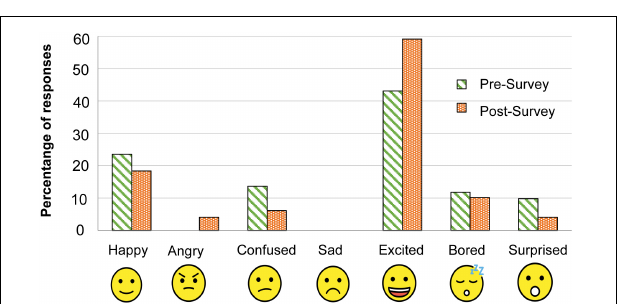
FIGURE 3 | Frequency of engagement sub-categories, positive and negative emotion. Results depicting the frequency of positive and negative emotions found in question 1 of the pre and post survey. These emotions were coded through thematic analysis of question 1, which asked students to “write and/or draw what you think of when you hear the word science.”